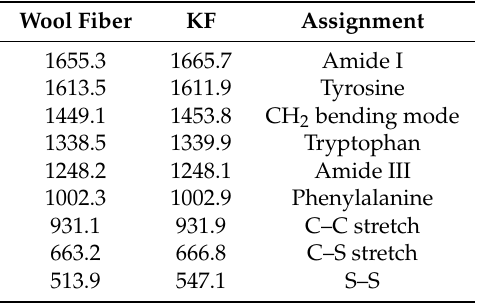
Table 1. Raman characteristic peak distribution of the test samples (cm − 1 ).